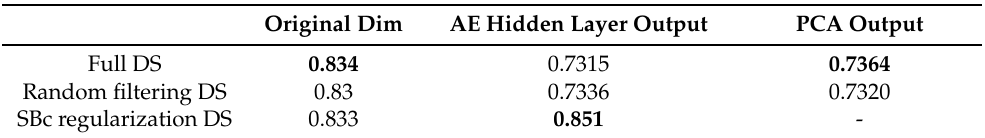
Table 4. Results of GB-based classification of the datasets with different filtering methods and different feature sets. The stabilized barycenter-based (SBc) method limits the cluster size to be in range 50–89%. The ID s obtained cluster size is 1709 with 730 of outliers ( UD